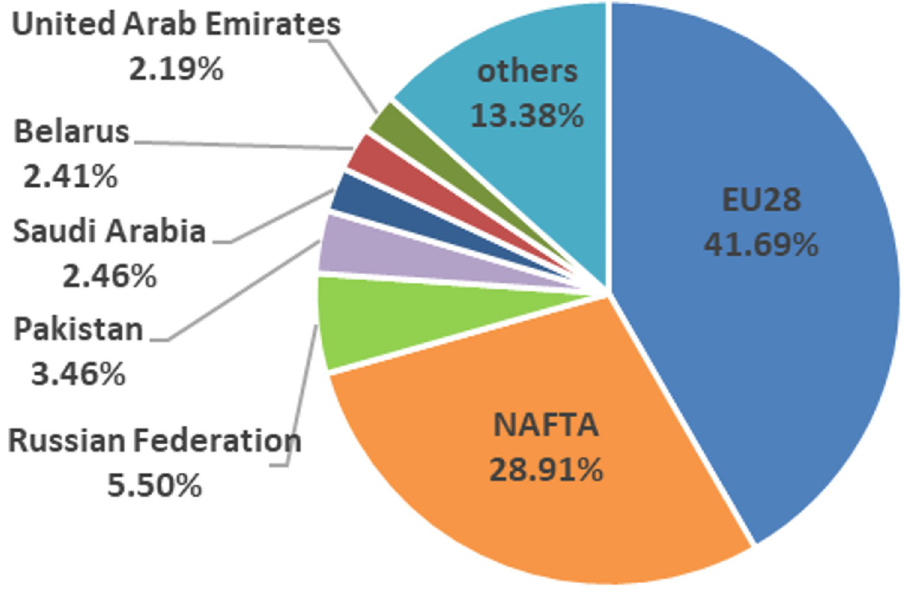
Fig 4. Main tomatoes importing regional commercial areas and countries (2016).